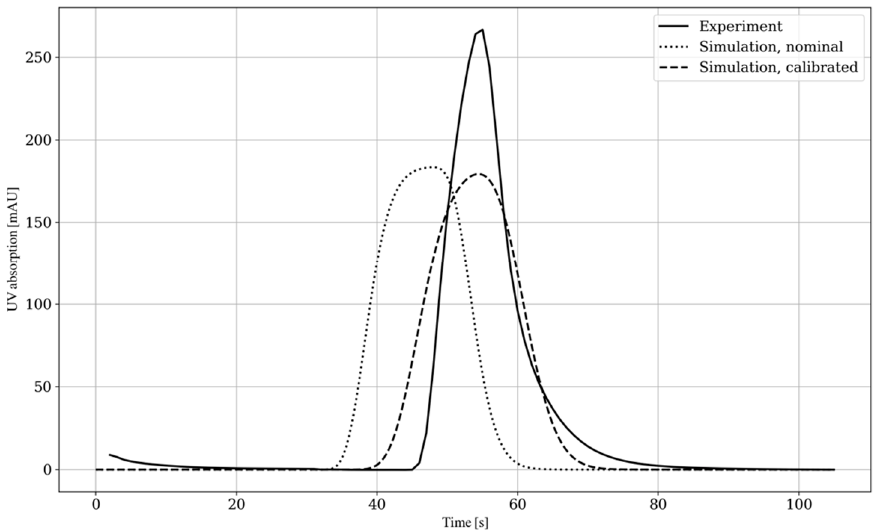
Figure 2. Calibration of the system’s dead volume without a column: experimental result (solid), nominal model response (dotted); calibrated model response (dashed).